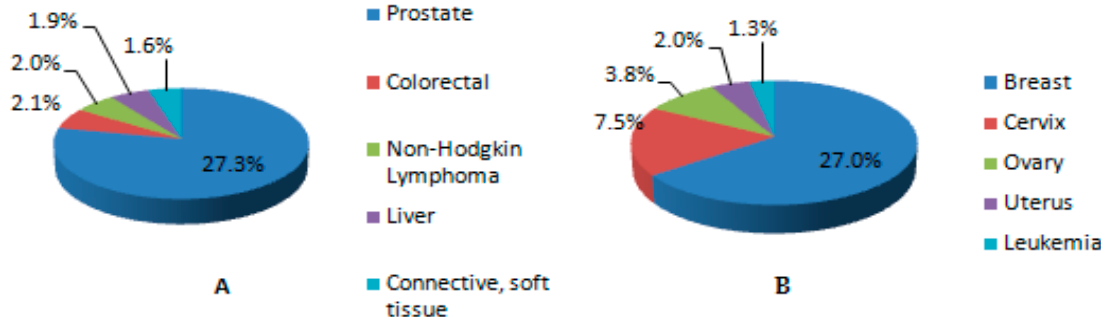
Figure 7. Five predominant cancers in both males ( A ) and females ( B ) living in Rivers State (Cancer in Nigeria, 2009–2013).